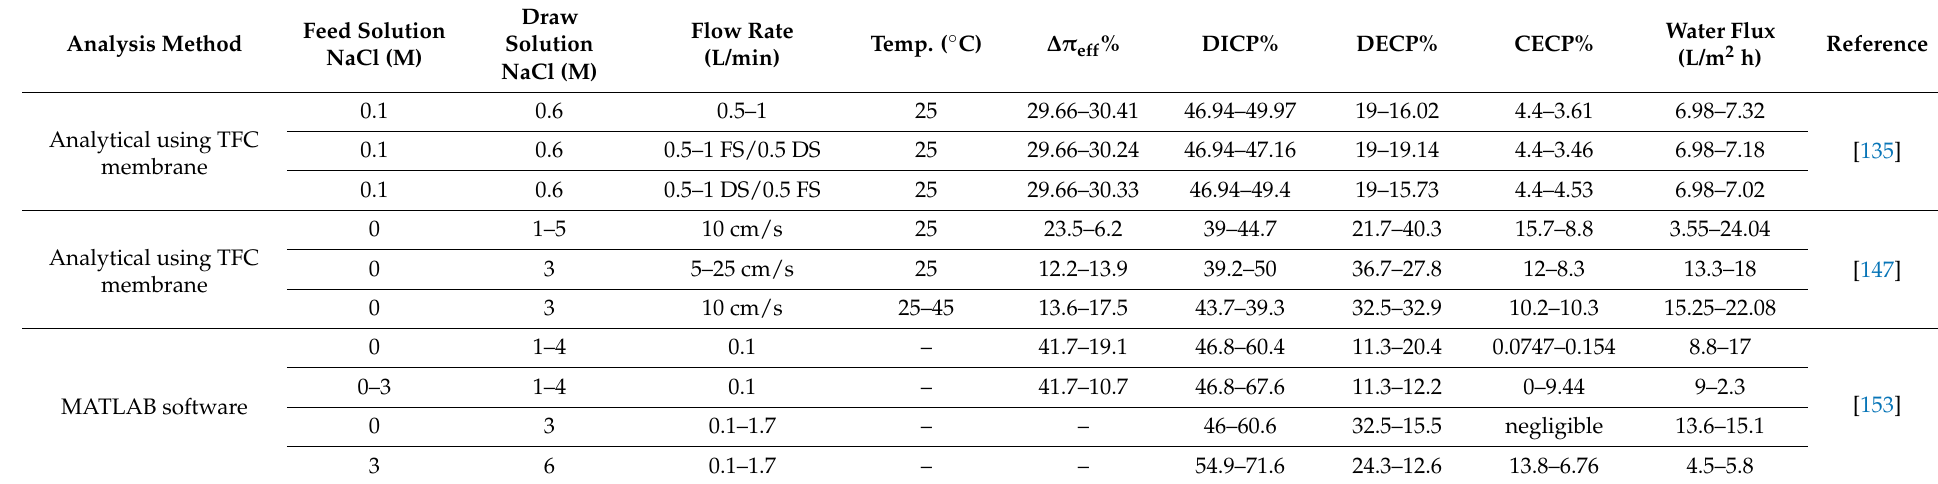
Table 4. Analysis method of the effect of concentration polarization (CP) on FO